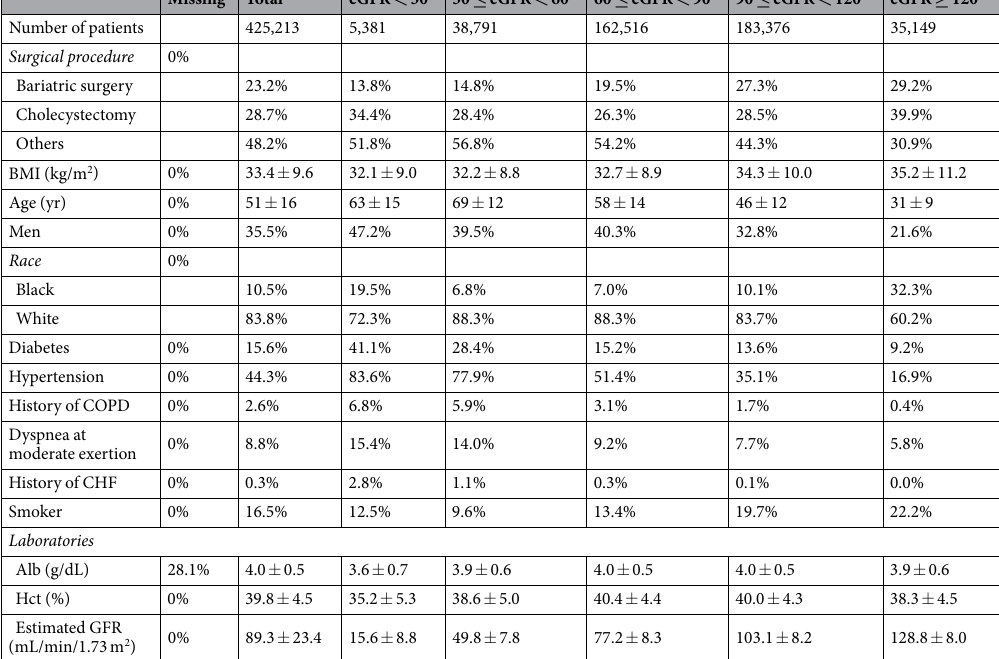
Table 1. Characteristics of patients. Values are expressed as means ± SD or percentage,